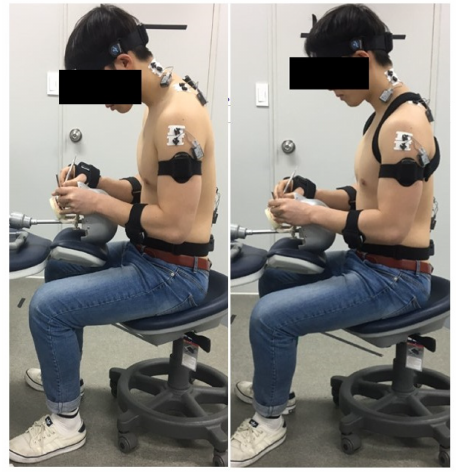
Figure 2. Manual scaling task with and without applying the 8-figure shoulder